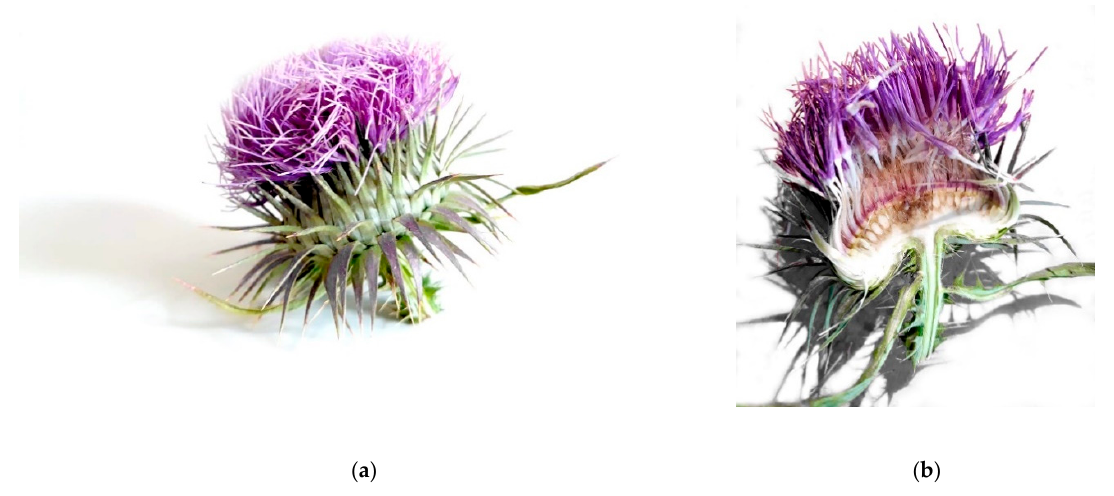
Figure 1. Inflorescence (flower head) of Onopordum tauricum ( a ) whole; ( b ) section.